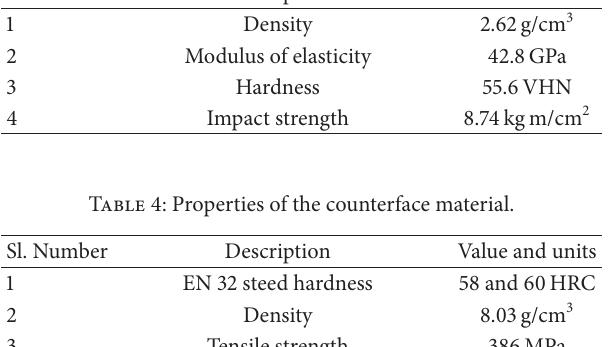
Table 3: Properties of the 20% red mud reinforced composites. Sl. Number